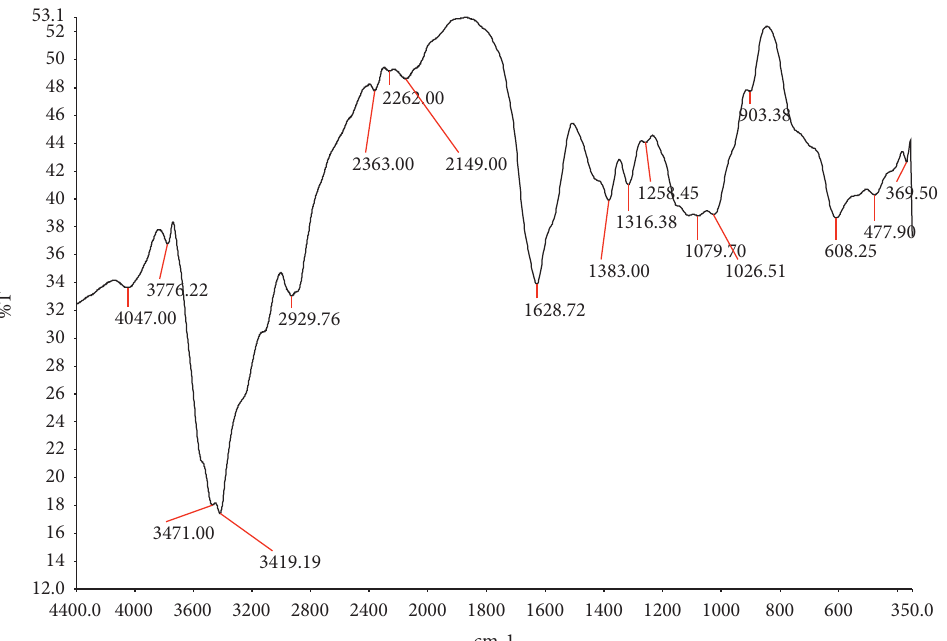
Figure 4: FTIR spectra of synthesized zeolite